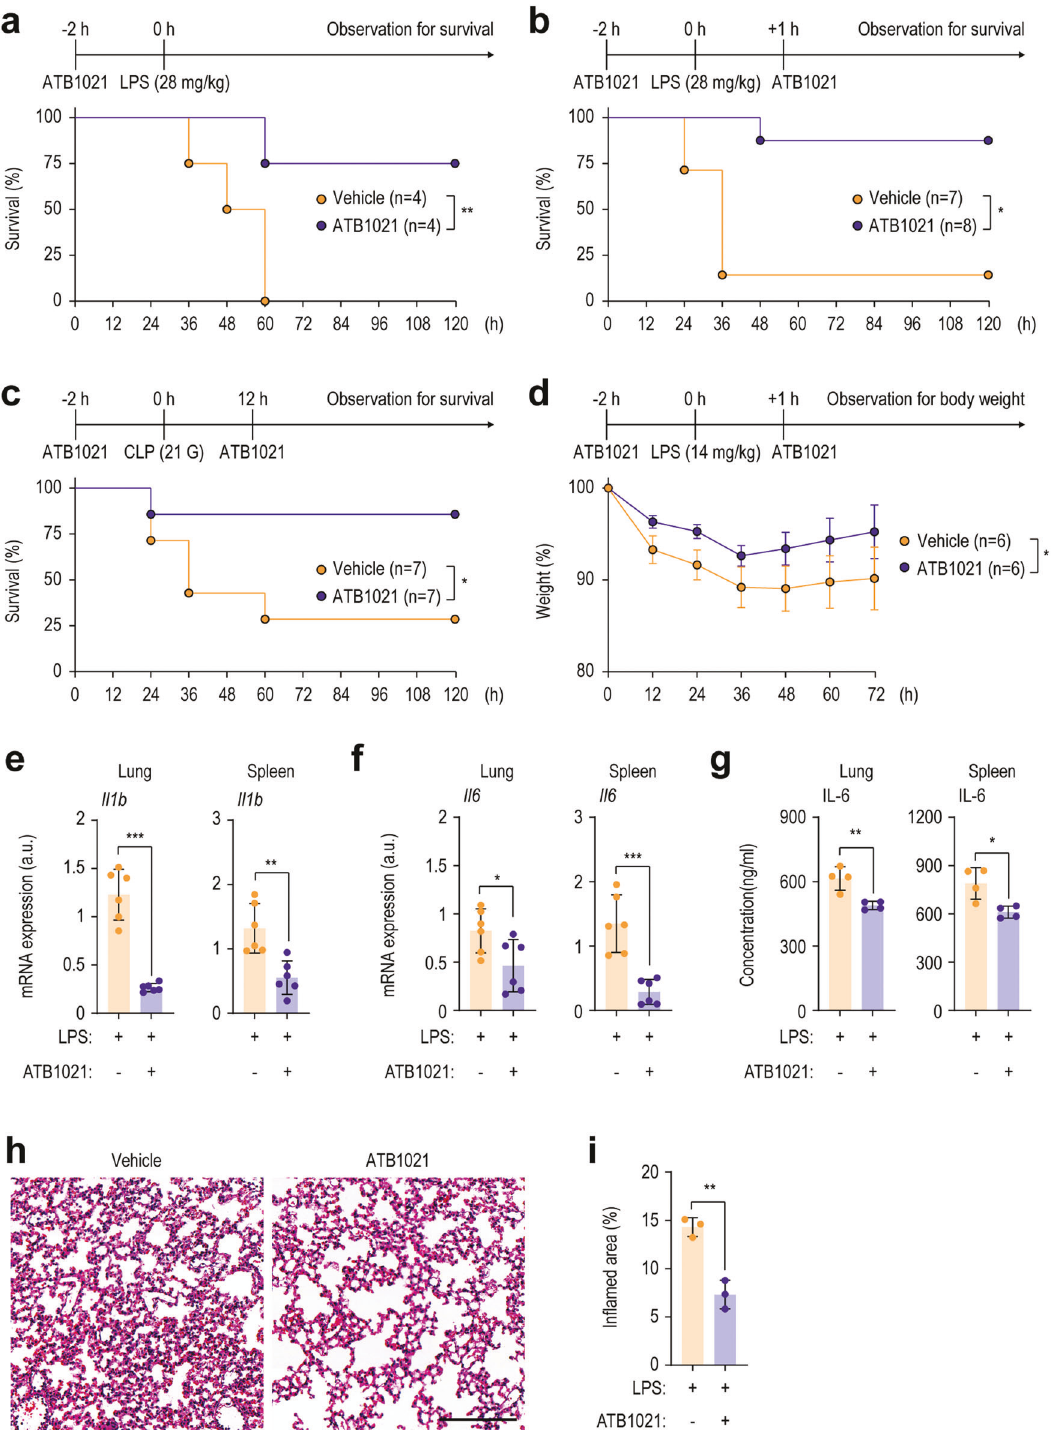
Fig. 1 A p62 ligand prevents systemic in fl ammation and mortality in vivo. a , b Survival of mice for 120 h after injection with LPS (28 mg/kg) and pretreatment for 2 h with ATB1021 (20 mg/kg) ( a , n = 4) or pre- and posttreatment for 2 and 1 h, respectively, with ATB1021 (20 mg/kg) ( b , n = 7 – 8). Flowcharts of the experiments are shown. c Survival of control or ATB1021-treated mice 120 h after CLP ( n = 7). Flowcharts of the experiments are shown. d Body weight observed for 72 h in vehicle- or ATB1021-treated and LPS-injected mice ( n = 6). e – g Quantitative PCR analysis of Il1b ( e ) and Il6 ( f ) mRNA levels and the IL-6 protein level ( g ) in lung and spleen tissues from mice treated with vehicle or ATB1021 for 2 h and injected with LPS (14 mg/kg) for 6 h ( n = 4 – 6). h , i H&E-stained images ( h ) and in fl amed areas ( i , n = 3) in the lungs of mice treated with vehicle or ATB1021 (20 mg/kg) and injected with LPS (14 mg/kg). Flowcharts of the experiments are shown with means ± SEM ( e – g , i ). The log-rank (Mantel ‒ Cox) test ( a – c ), Mann ‒ Whitney U test ( e , f , i ), or two-tailed Student ’ s t test ( g ) was used to determine statistical signi fi cance. LPS lipopolysaccharide, CLP cecal ligation and puncture. * p < 0.05, ** p < 0.01, *** p <